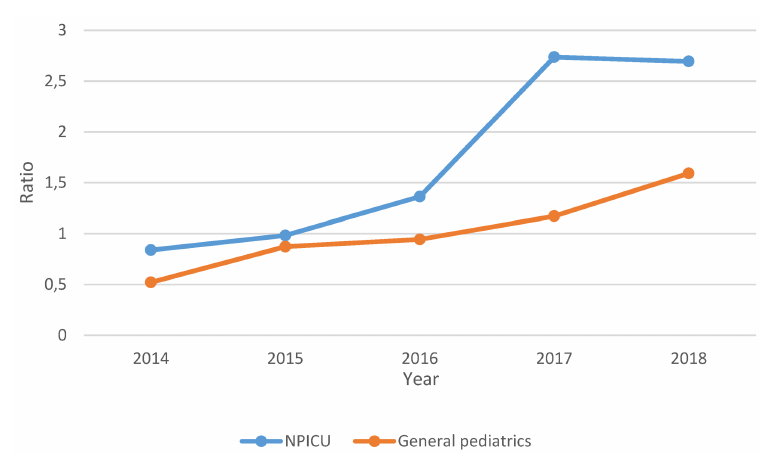
Figure 6: Penicillin-cephalosporin